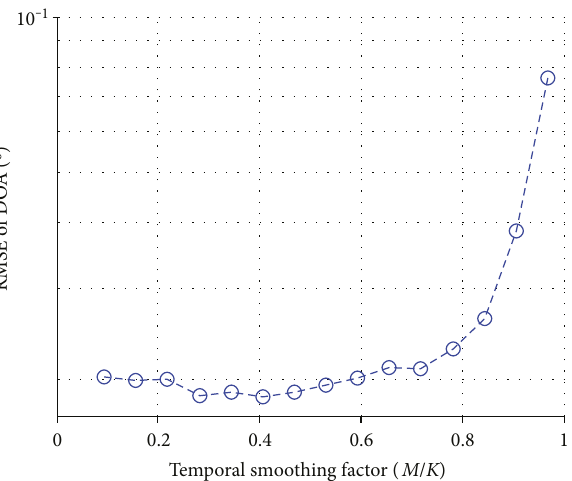
Figure 4: E ff ect of the number of spatial beams on the DOA estimation error.